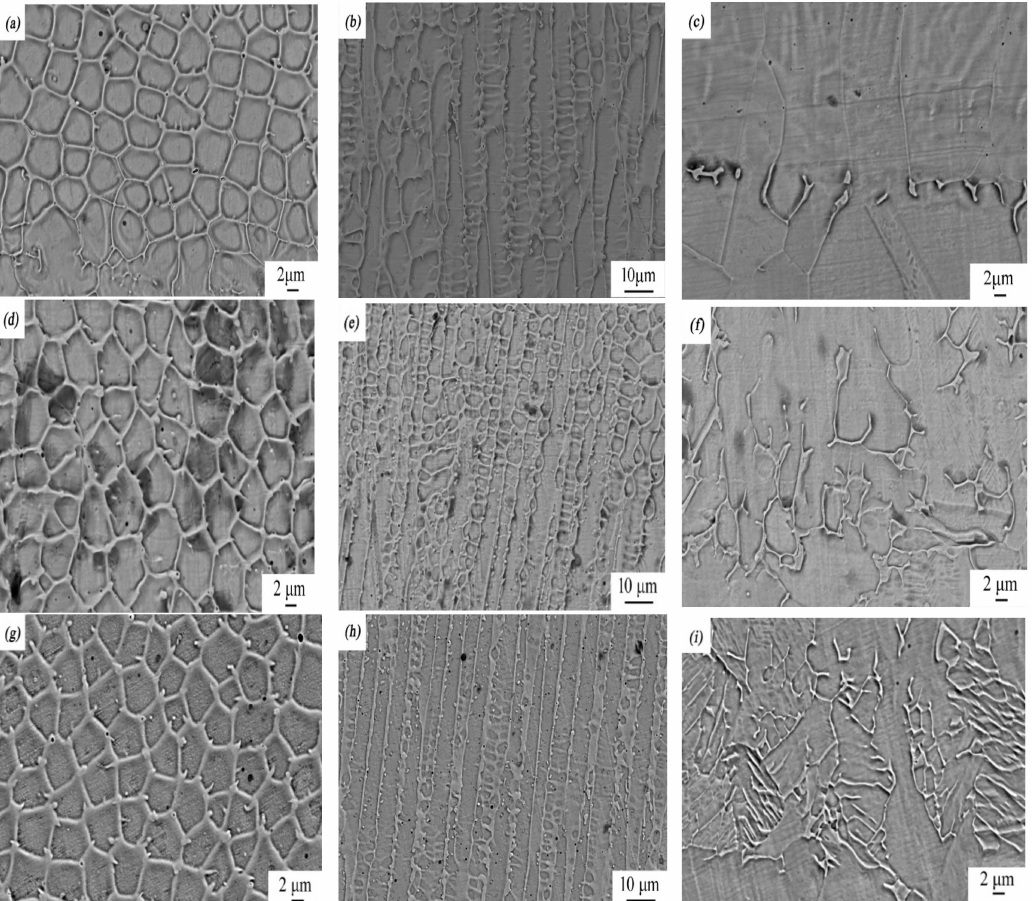
Figure 4. SEM micrographs of rare earth oxide-modified 316L cladding layer: ( a ) the top, ( b ) middle, and ( c ) bottom part of the laser-cladding layer when no rare earth was added; ( d ) the top, ( e ) middle, and ( f ) bottom part of the laser-cladding layer modified using 2 wt % La 2 O 3 ; ( g ) the top, ( h ) middle, and ( i ) bottom part of the laser-cladding layer modified using 2 wt % CeO 2